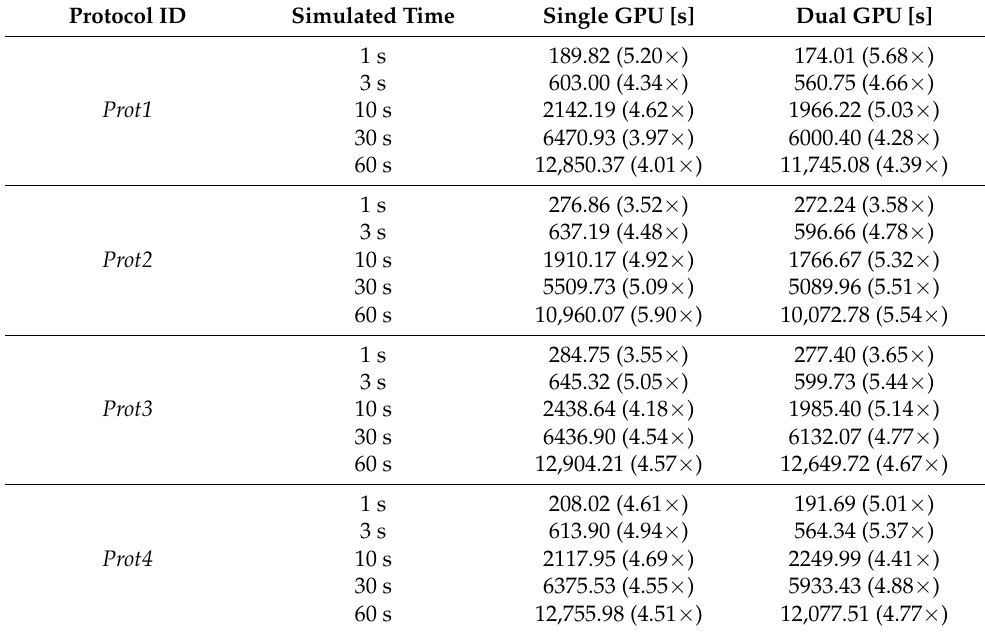
Table 7. Processing time for the network Network2 . The speed-up is indicated between